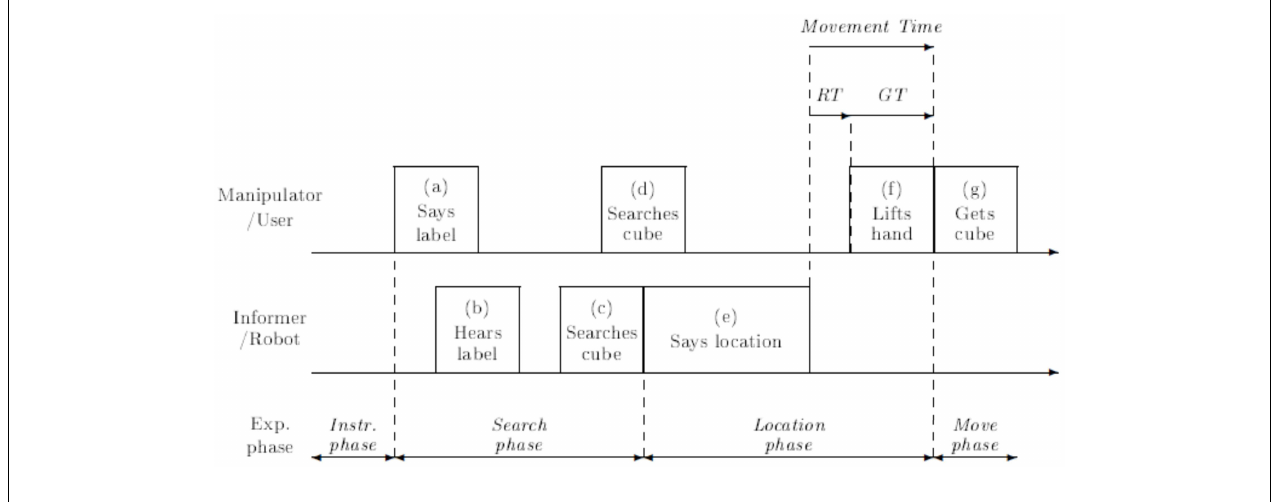
(e) to manipulator’s hand contact on the cube (f). Move phase: the rest of the hand movement, from the cube contact to the initial position. RT is the reaction time, from the end of Says location (e) to the beginning of movement onset (f). Grasp time (GT) is from movement onset, to contact with the cube. Movement time is the sum RT and GT. Note that if the manipulator lifts the hand (f) before the end of Says location (e), then the RT will be negative, i.e.,